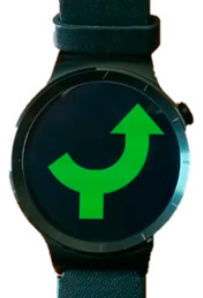
Figure 2. Participant wearing the bone conduction headphones.